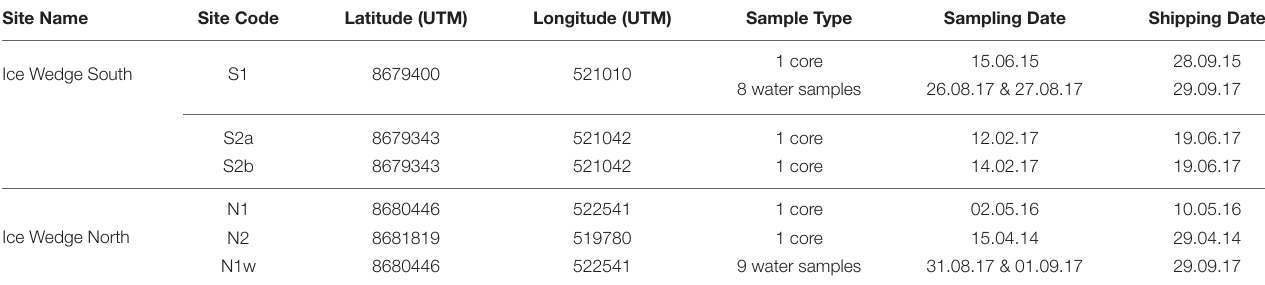
TABLE 1 | Sampling locations, in UTM zone